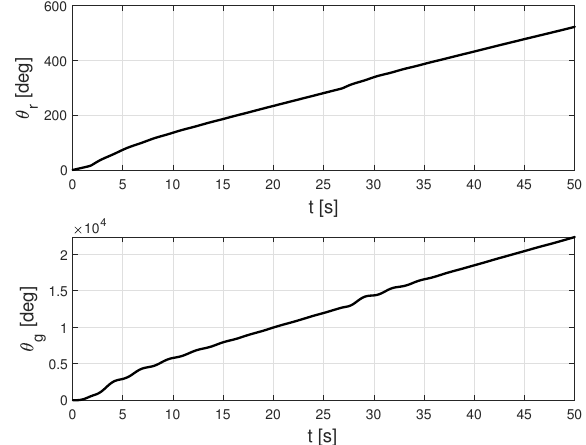
Figure 8. Angular displacement.